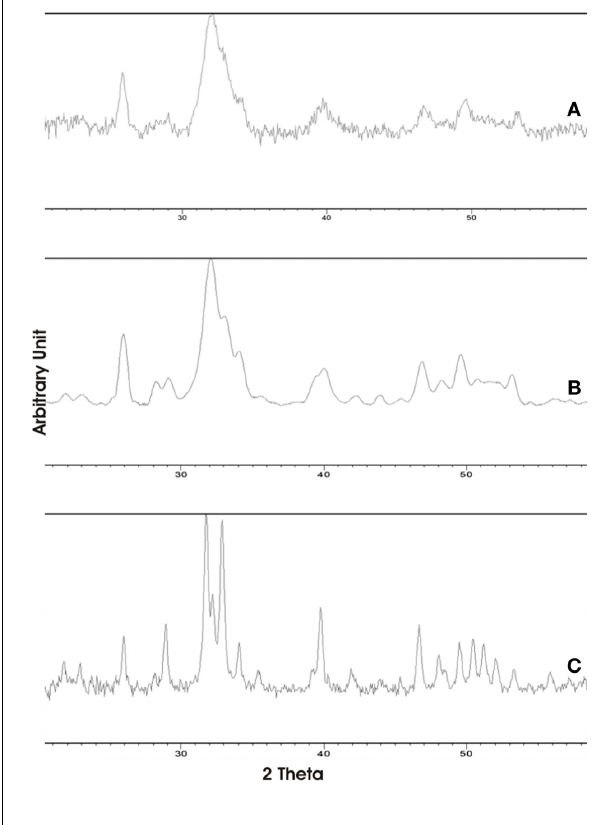
FIGURE 2 | X-ray diffraction patterns collected for synthetic biomimetic CHA nanocrystals (A), CHA nanostructured microcrystals (B), and human tooth enamel